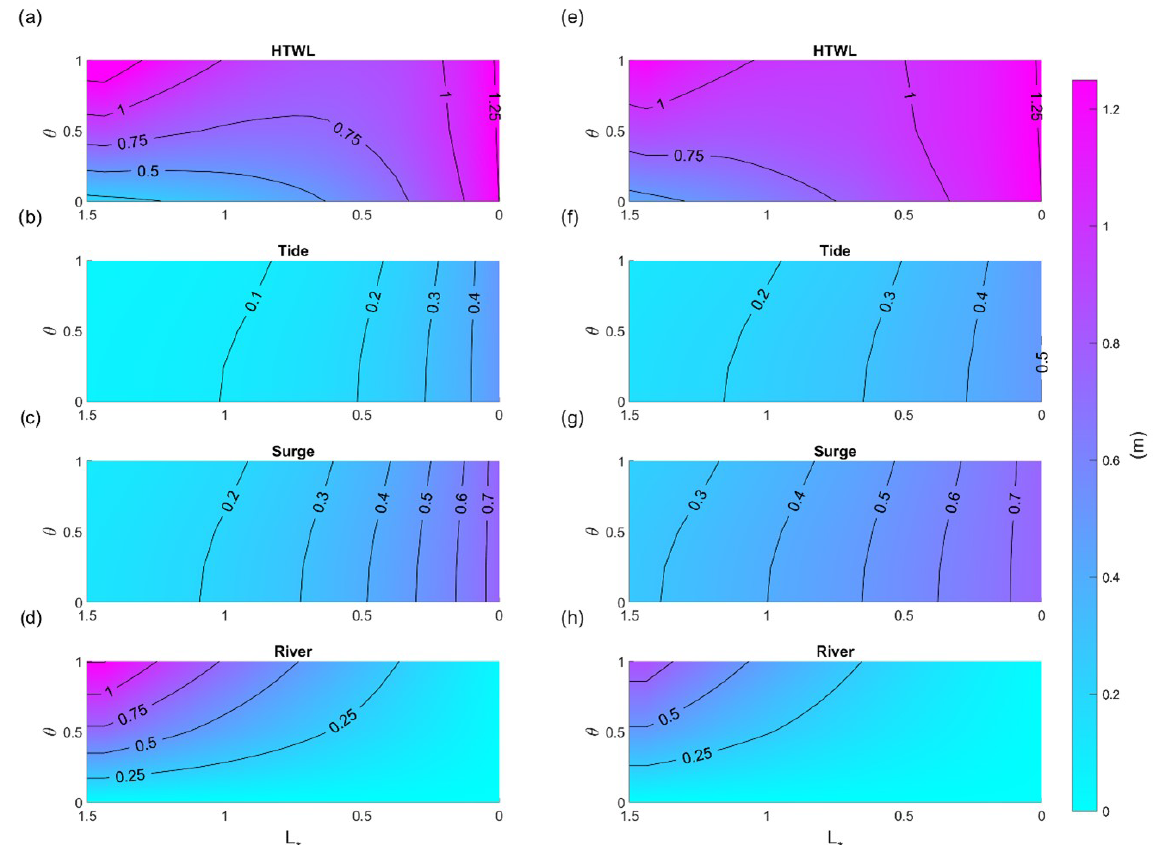
Figure 10. Combined contribution of tide, surge, and river flow to water level for depths of 5m (left panel subplots) and 10m (right panel subplots). Colors and the labeled contours denote water level. The total water level (a, e) is the combination of tidal amplitude (b, f) , surge amplitude (c, g) , and water level from river discharge (d, h) . The period of the primary surge (Su Pri ) is 24h, the convergence length scale is 80km, the x axis represents the dimensionless coordinate system of L ∗ = x/L e (origin at estuary mouth, on the right-hand side), and the (cid:19) (cid:18) | u r | y axis shows the nondimensional river flow θ = (cid:12) (cid:12) (cid:12) u D 2 (cid:12)